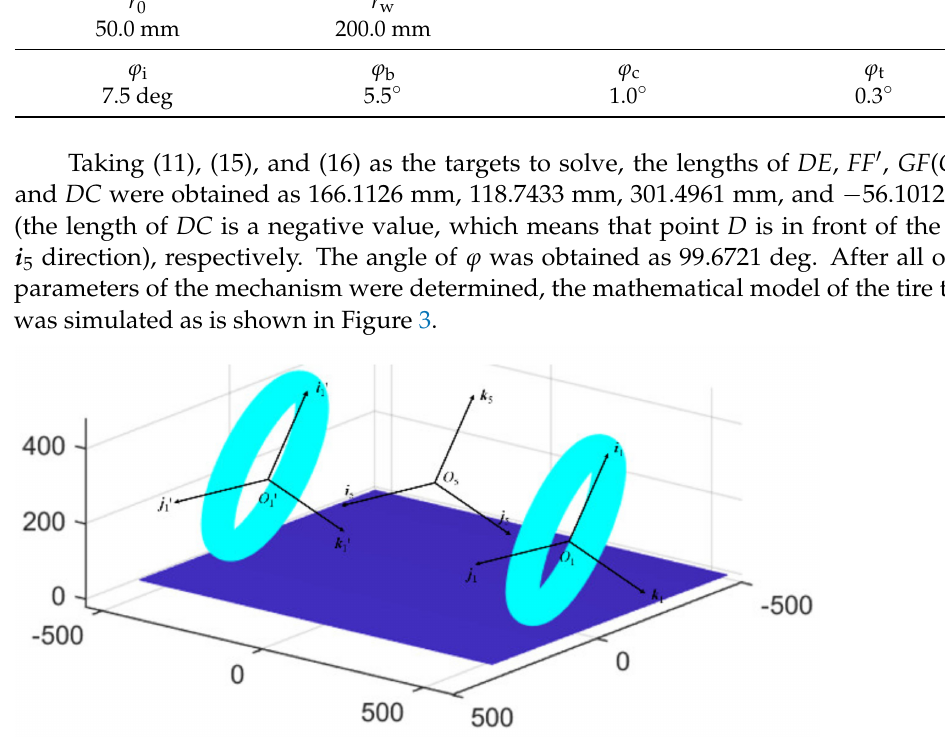
Figure 3. Mathematical model of wheel tire